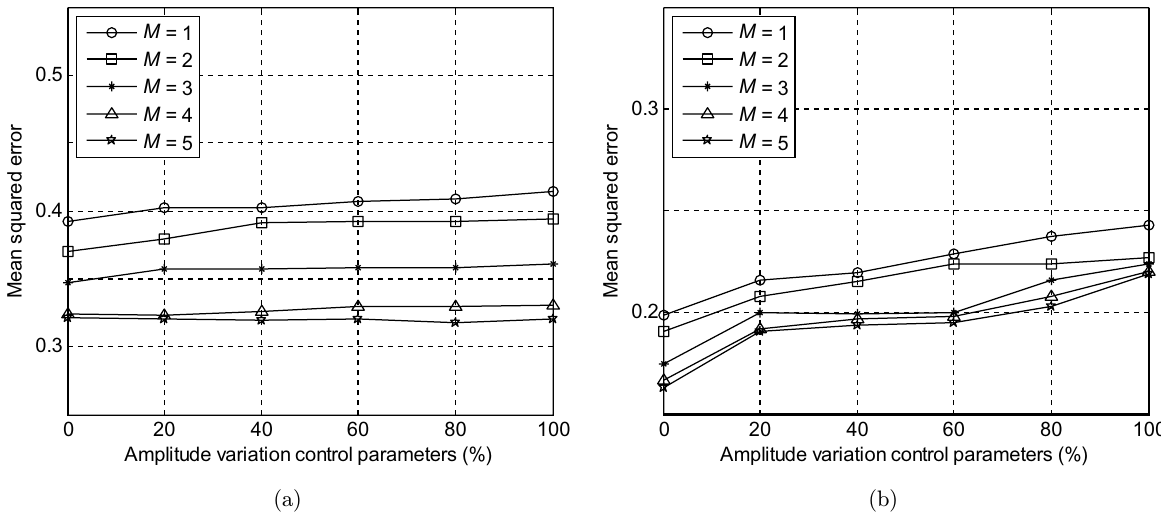
Fig. 7. Performance comparations of EEMD-BRLS in di®erent half-window length M . (a) The MSE of concentration changes of oxyhemoglobin and (b) the MSE of concentration changes of